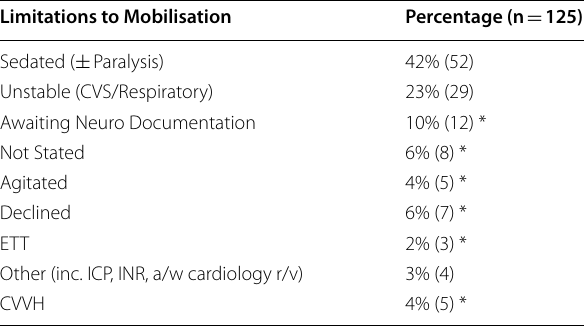
Table 1 Documented barriers to